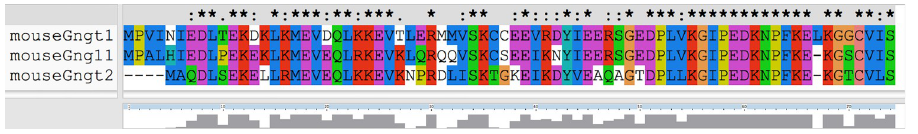
Fig 1. Multiple amino acid sequence alignment of mouse rod G γ 1 ( Gngt1 ), cone G γ c ( Gngt2 ), and G γ 11 ( Gng11